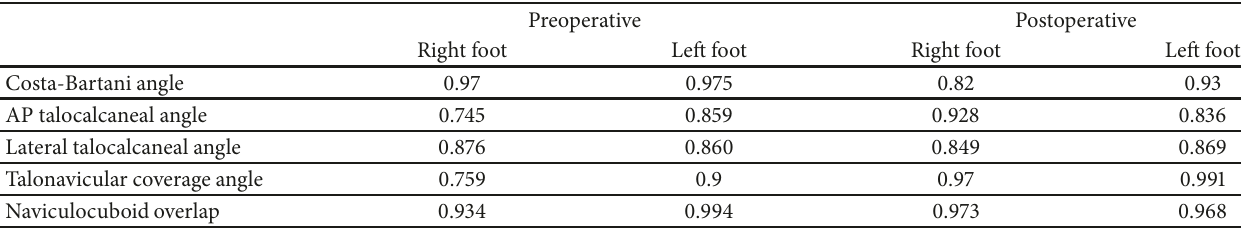
Table 2: Degree of interobserver correlation. It will be noted that measurements range from 0.8 to close on 1, indicating a very high degree of correlation.